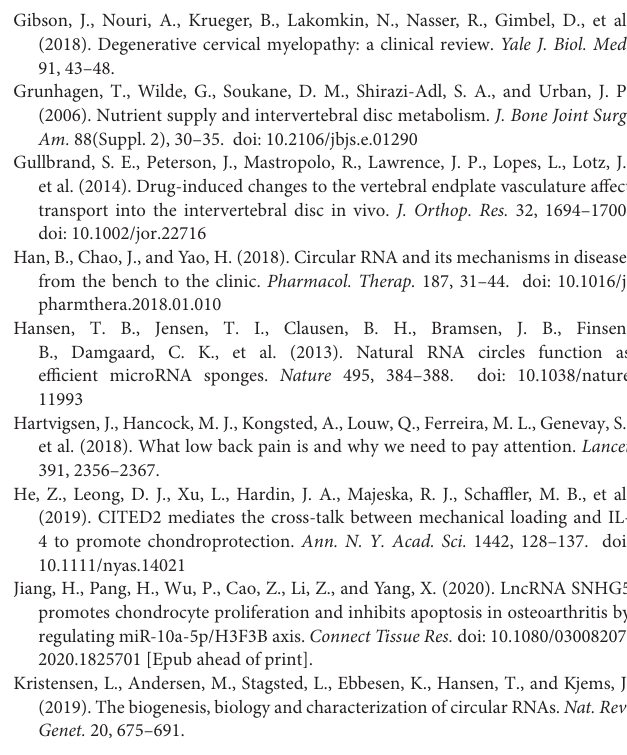
Supplementary Table 1 | Selected patient characteristics. Supplementary Table 2 | Primers and sequences used in this